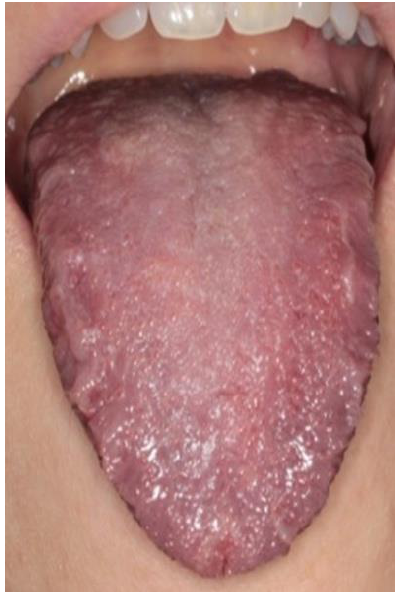
Figure 3. One-week follow-up. Complete healing.